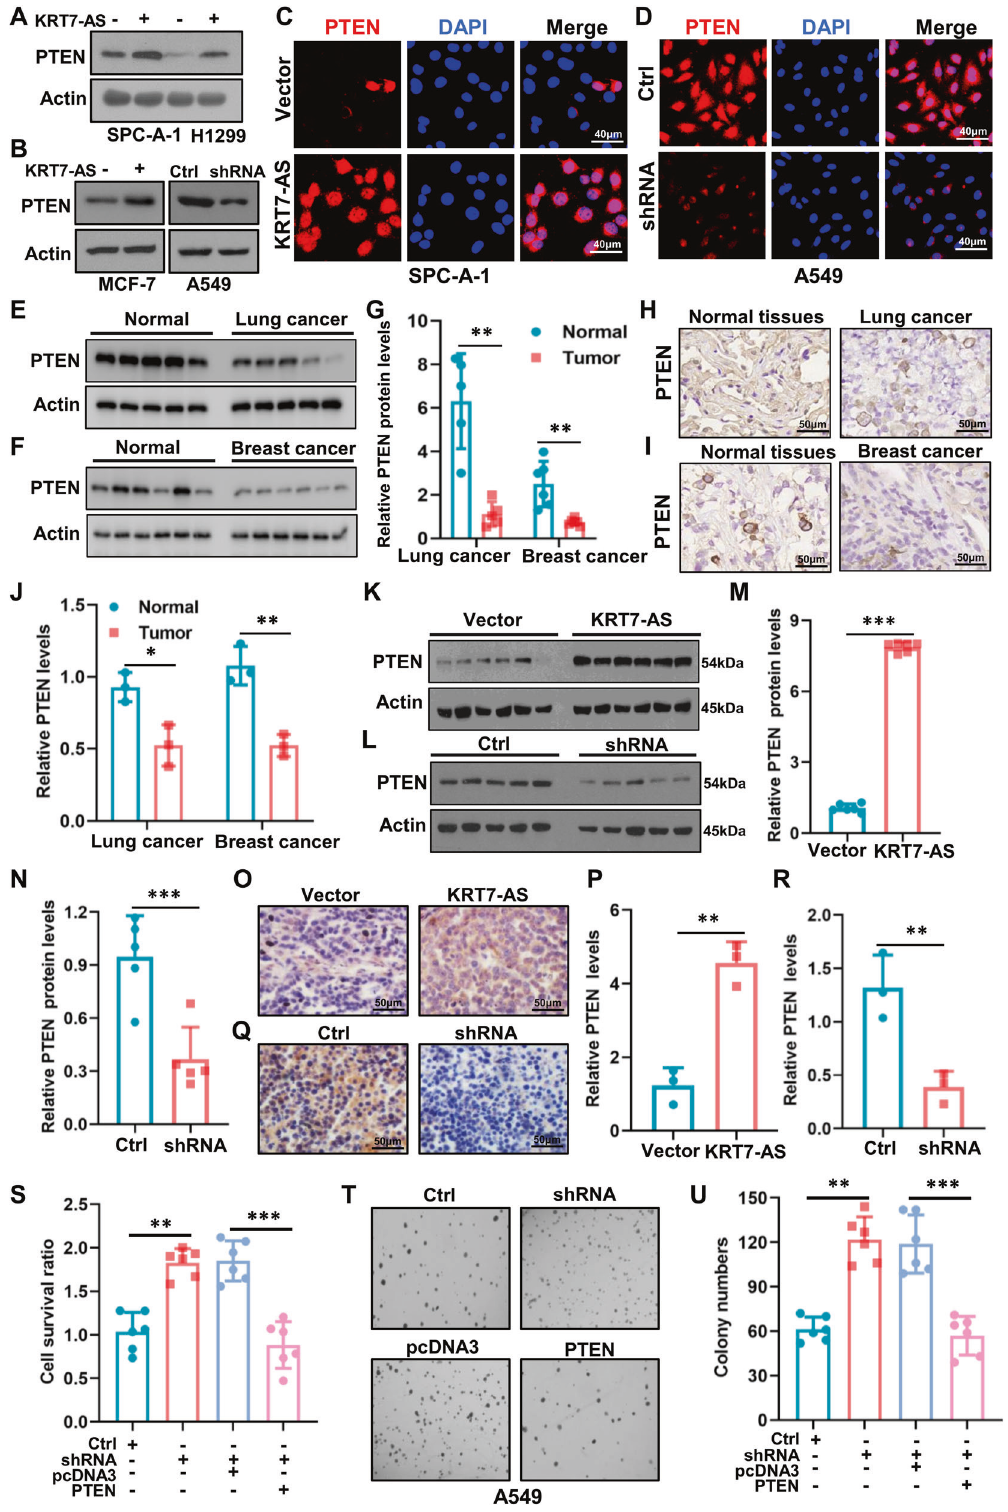
Fig. 7 KRT7-AS elevates amounts of the key tumor suppressor PTEN in cancer cells and inhibits tumorigenesis. Western blotting showed that overexpression of KRT7-AS elevated PTEN protein levels in SPC-A-1 and H1299 lung cancer cells ( A ), and in MCF-7 breast cancer cells ( B ), whereas silencing of KRT7-AS reduced the levels of PTEN in A549 lung cancer cells ( B ). The effect of either overexpression of KRT7-AS or silencing of KRT7-AS on PTEN levels in SPC-A-1 cells ( C ) and A549 lung cancer cells ( D ) was accessed by IF staining. Expression of PTEN in lung cancer ( E , G ) and breast cancer tissues ( F , G ), and their paired normal tissues ( E – G ) was detected by Western blotting. PTEN protein levels in lung cancer ( H , J ) and breast cancer ( I , J ) tissues were measured by IHC staining. The effect of KRT7-AS on PTEN levels in the tumor tissues from the xenograft mice was accessed by western blotting ( K – N ) and IHC staining ( O – R ), respectively. Cell viability and colony formation were detected in KRT7-AS-silenced or PTEN re-overexpressed A549 cells, and control cells ( S – U ). Data are shown as mean ± SD of three independent replicates. ** P < 0.01, *** P < 0.001. Cell Death and Disease (2023)